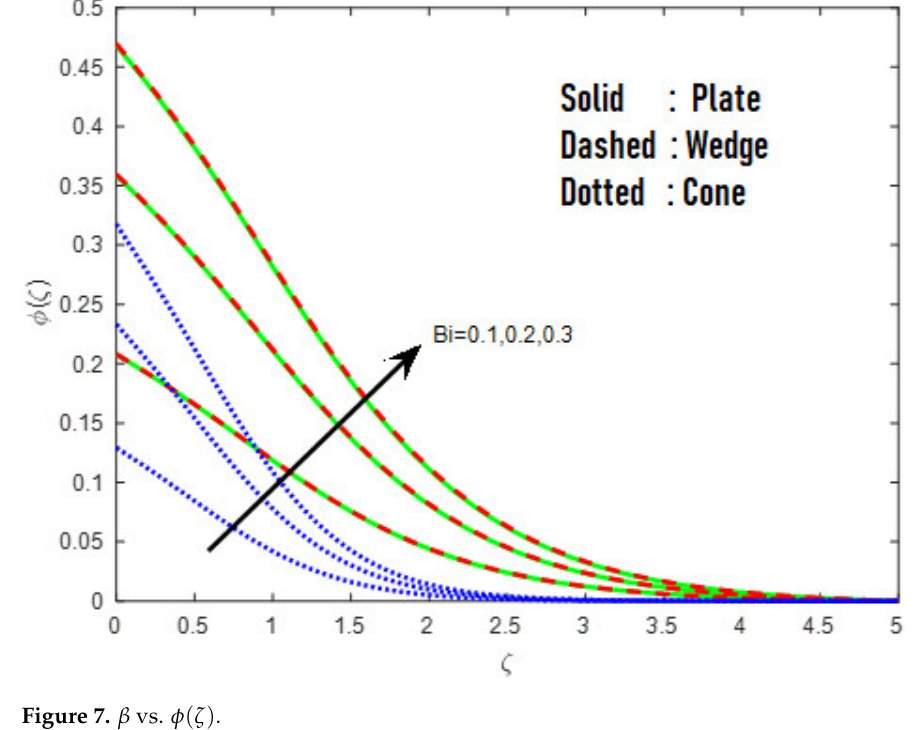
Figure 7. β vs. φ ( ζ ) . Figure 7.  vs. Figure 7.  vs.     .